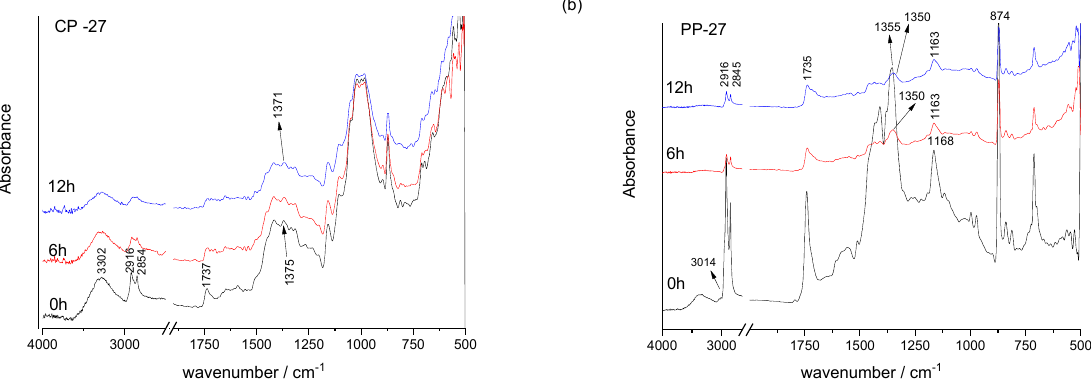
Figure 4. FTIR spectra of the TC45 ink on cellulose-based ( a ) and polypropylene-based ( b ) paper before and after exposure to UV radiation. In the case of all prints, the ink penetrates into the surface of cellulose-based paper but stays over the surface on polypropylene-based printing substrate since it is not absorbent, as confirmed by the surface roughness measurements as well (Table 2). This results in sharper IR vibrational bands of printing ink binders. Mineral and vegetable oils used in the formulation of printing inks are mobile and can penetrate into the cellulose- based printing substrate [46]. Thus, a significant contribution of the cellulose bands can be noticed in FTIR spectra of TC prints for TC27 and TC45 ink printed on cellulose-based printing substrate, especially in the fingerprint region from 1450–1200 cm − 1 and 1160–1000 cm − 1 range (Figures 2 and 3). Table 3. Vibrational bands of UV curable TC print and their assignations [47–53]. Band (cm − 1 )